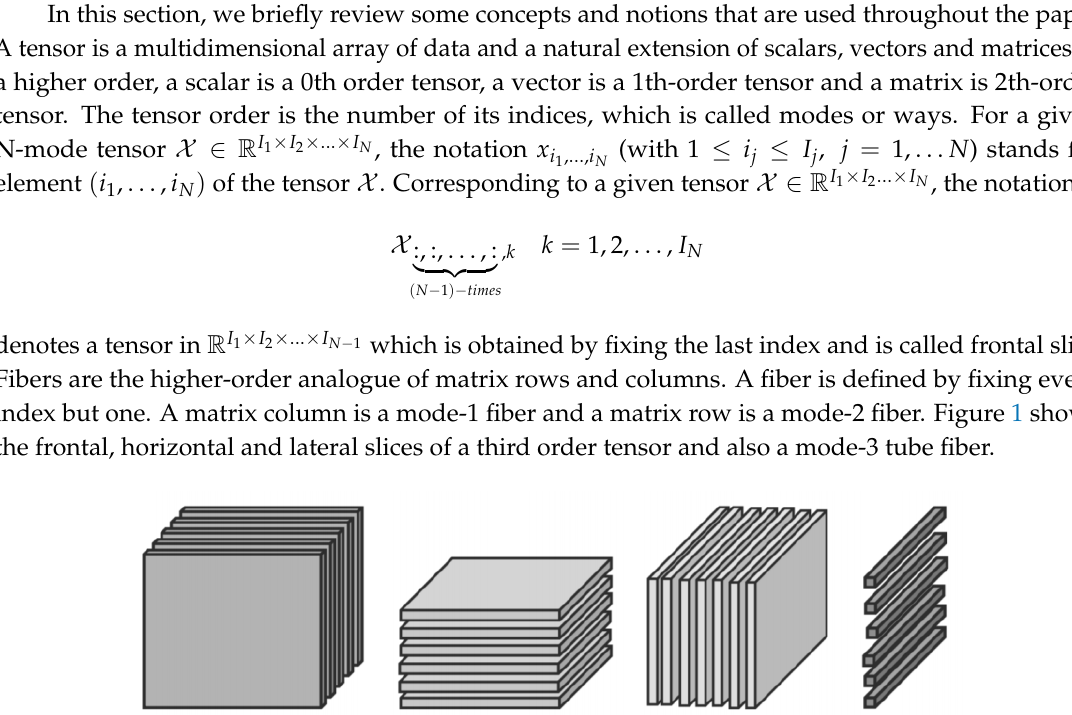
and arranges the mode-n n ) ∈ R I n × ( I 1 ... I 3 ... I n − 1 I n + 1 ... I N ) with n = 1, . . . , N . We n )